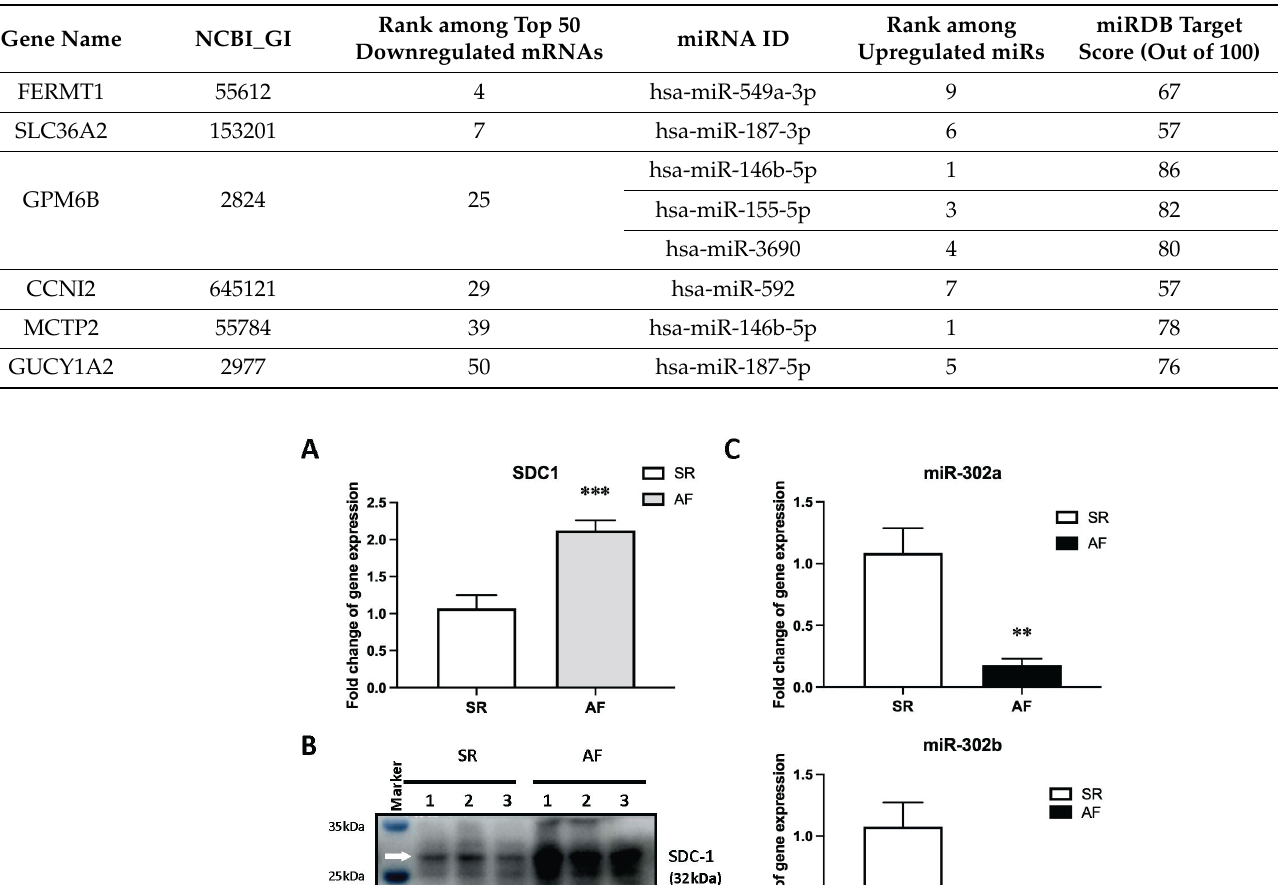
Table 4. Overlapping genes between predicted targets of top 9 upregulated miRs and top 50 negatively enriched genes in GSEA.